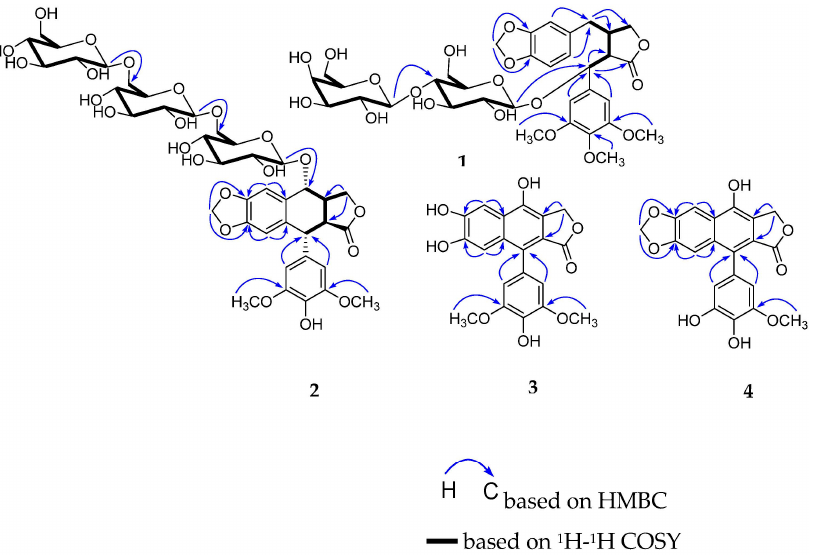
Figure 2. Key 1 H- 1 H COSY and HMBC correlations of compounds 1 – 4. Table 1. 1 H NMR (500 MHz) and 13 C NMR (125 MHz) data (DMSO- d 6 ) of 1 – 2.